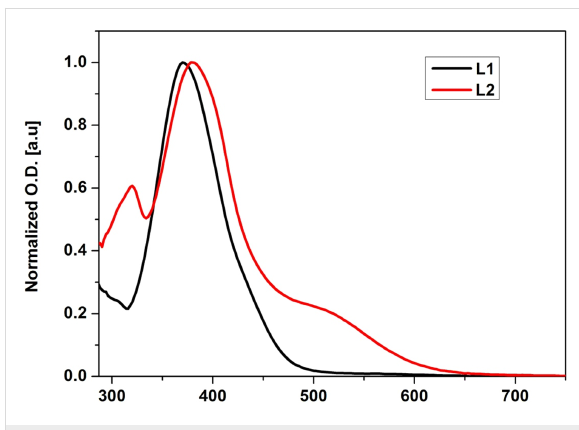
Figure 4: UV–visible absorption spectra of ligands L1 and L2 ( c 2.5 × 10 − 5 M in (dichloromethane/acetonitrile, 9:1, v/v)), room